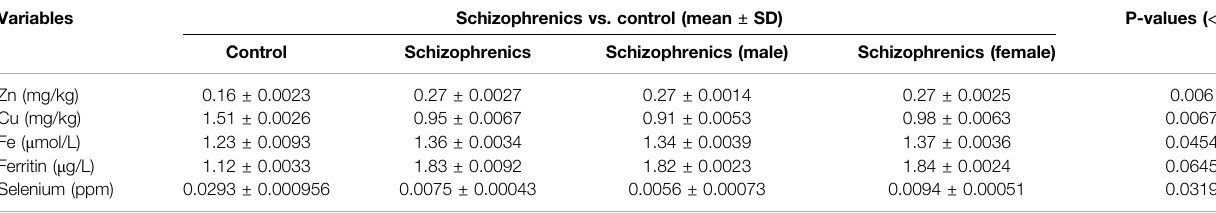
TABLE 7 | Trace elements pro fi le of schizophrenics versus controls.